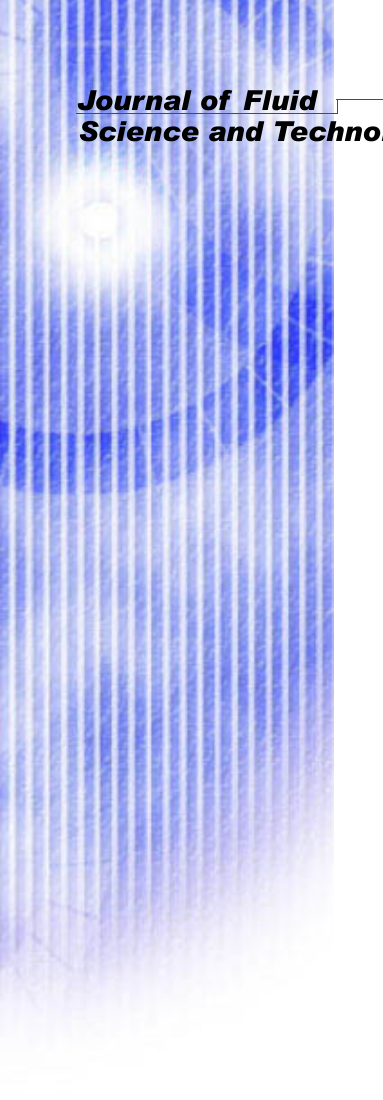
both in the Ekman layer and in the interior, and the non-uniformity due to stratification is not apparent. The left-most column of Fig. 9 is for an impulsive spin-up. As is evident, the meridional circulation is confined near the endwall disks as the stratification increases. This